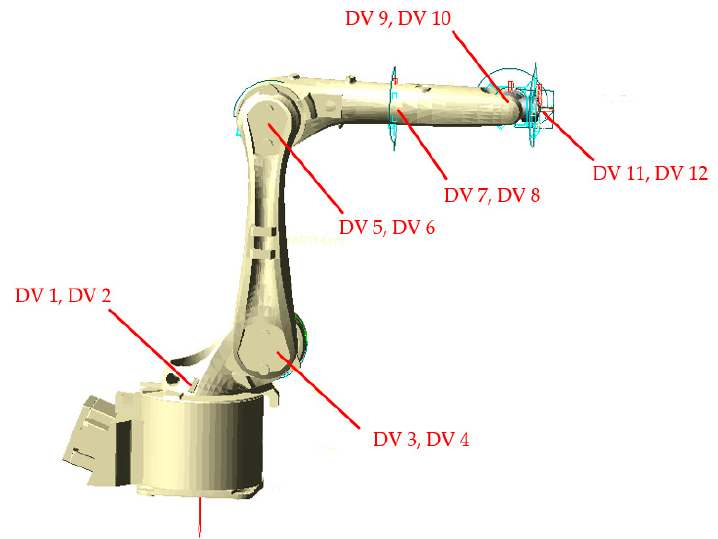
Figure 7. Diagram of parameter setting at each joint.